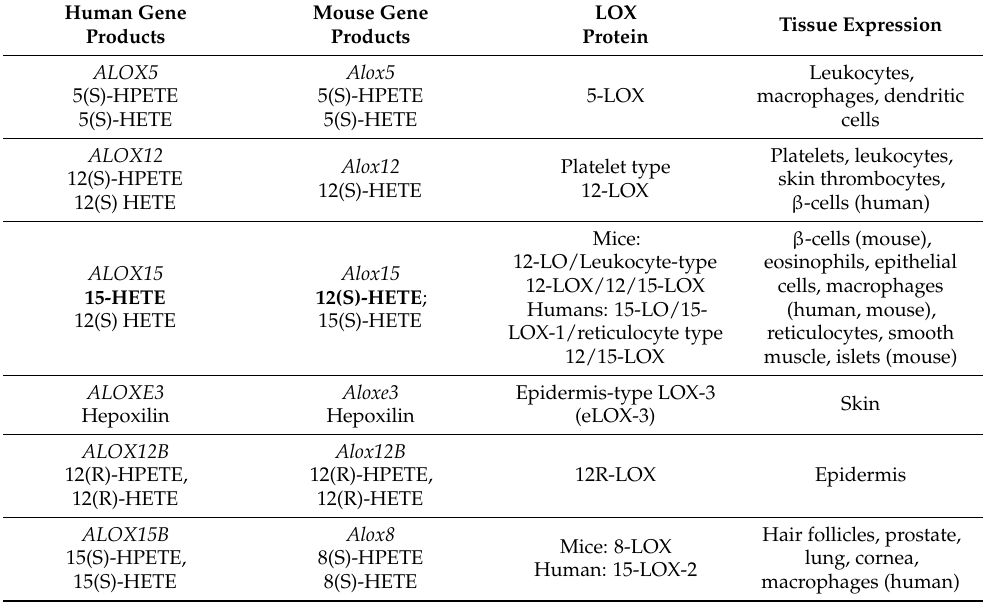
Table 1. LOX-encoding genes across